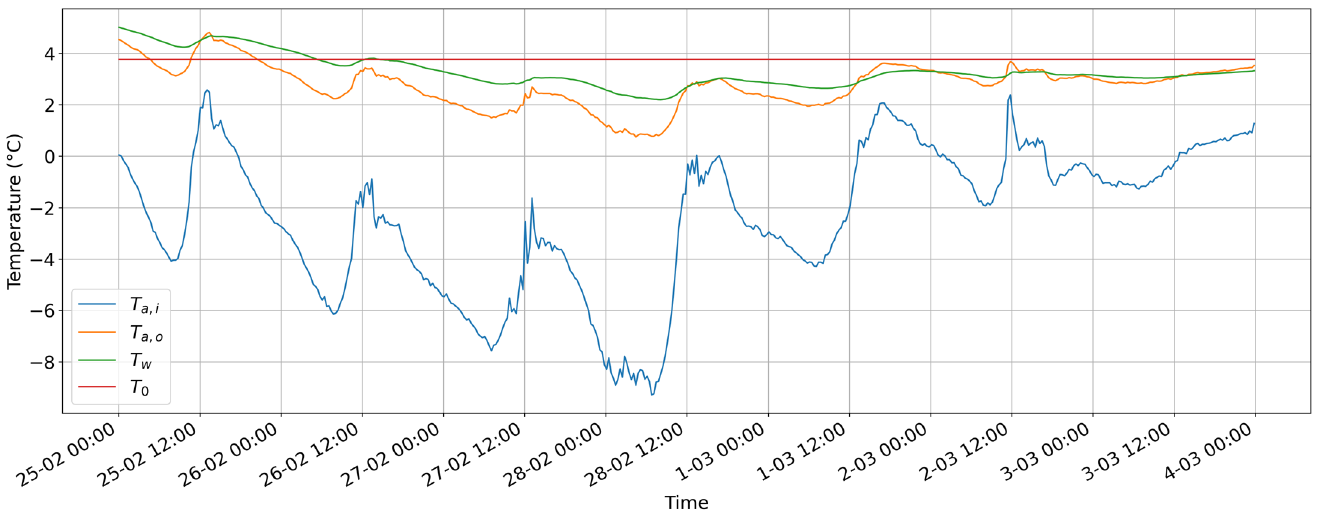
Figure 3. Measured temperatures (°C) at the inlet and outlet of the pipe compared to the estimated reference temperature during the coldest week of 2018 (25 February to 3 March).